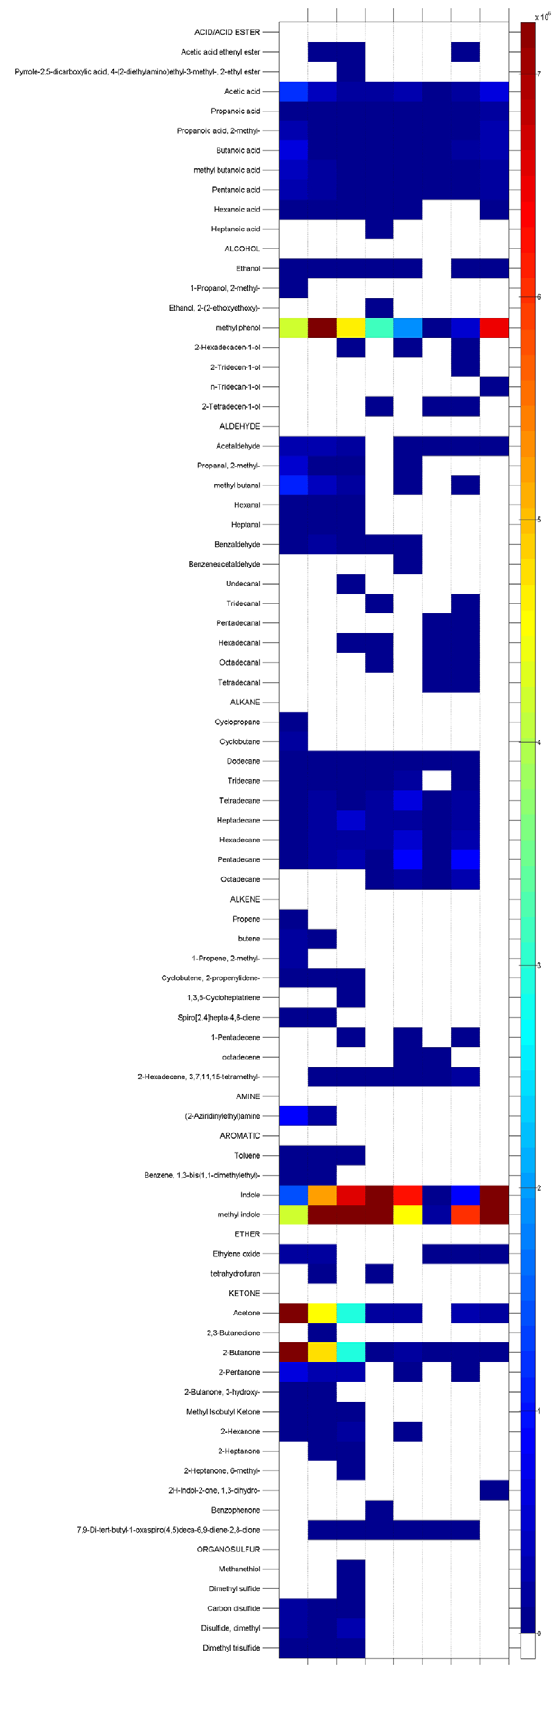
Figure 3. Fiber-dependent GC-MS identification and analysis of metabolites present in the human fecal VOC metabolome. A heat map presents the identified metabolites extracted by each SPME fiber and their relative chromatographic peak areas. Each of the eight columns in the heat map represents a different fiber. Metabolites are indicated on each row and are organized by functional group. Each extraction was performed in duplicate and replicates combined by averaging peak area values. Fiber legend: A - 75 m m CAR-PDMS, B